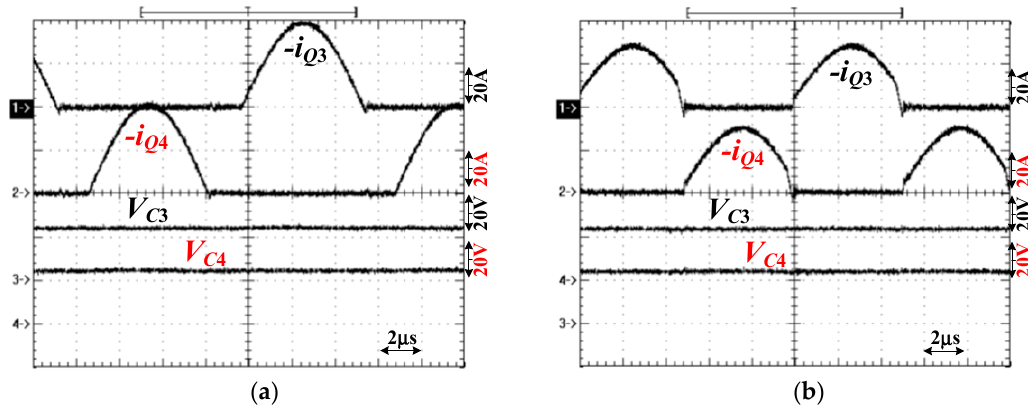
Figure 8. Test results of − i Q 3 , − i Q 4 , V C 3 , and V C 4 under 480 W output with ( a ) V 1 = 350 V and ( b ) V 1 = 400 V.